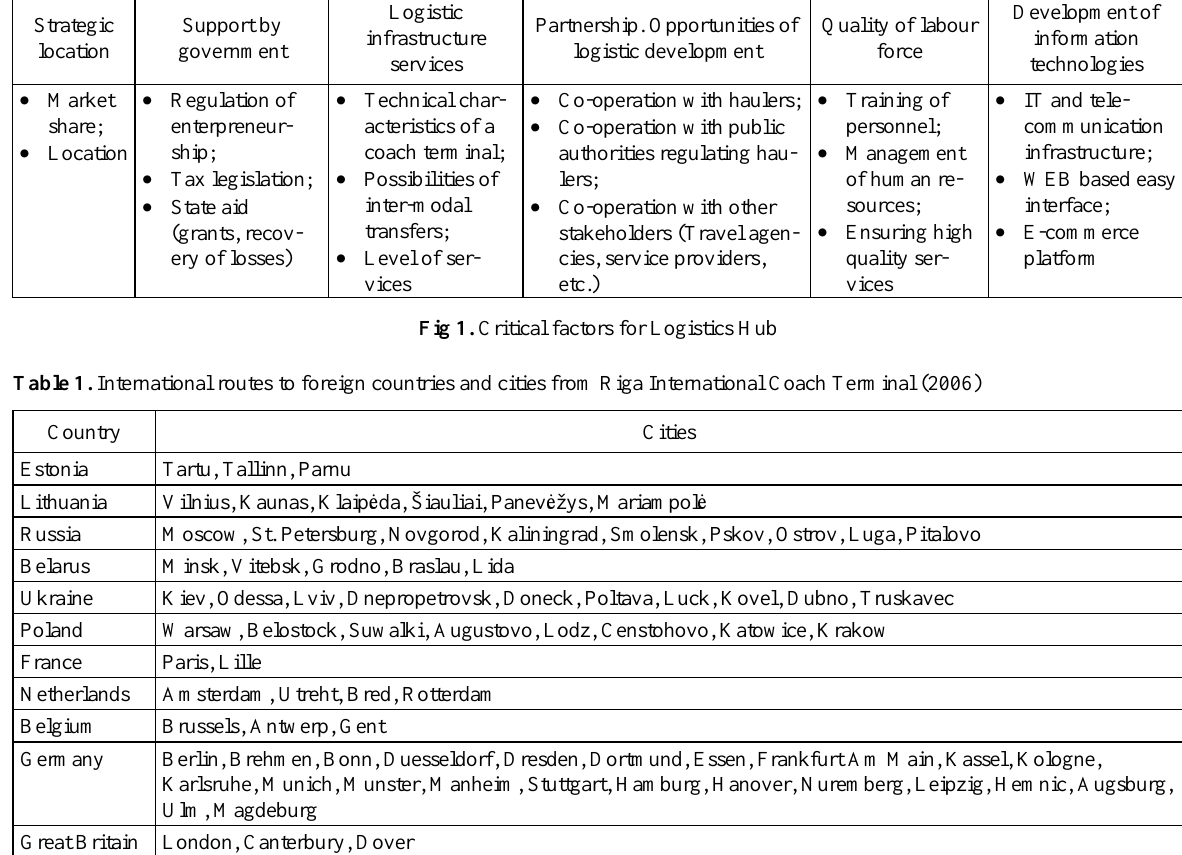
Average number of routes per day